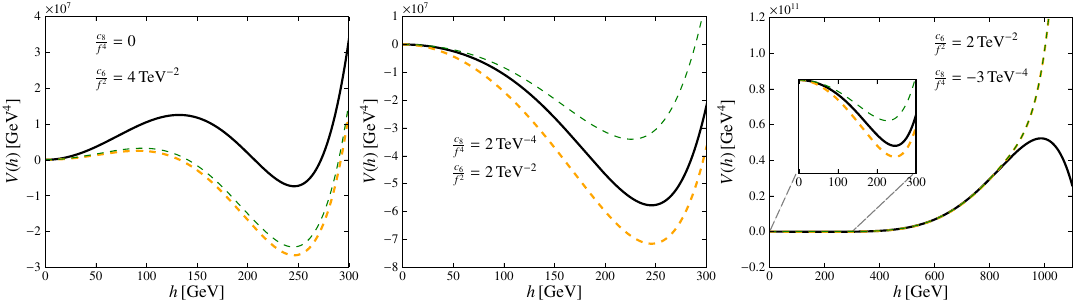
Figure 1 . The potentials V tree (black solid curve), V 1 ‘ at T = 0 (orange dashed curve) and V 1 ‘ at T = T x (green dashed curve) for the choices of c 6 =f 2 and c 8 =f 4 indicated in each panel. In the left panel, there exist two vacua already at zero temperature ( (cid:22) 2 ’ (cid:0) 3100 GeV 2 , (cid:21) ’ (cid:0) 0 : 23, T x = T c = 35 GeV ). In the central panel, the existence of two vacua arises only at (cid:12)nite temperature ( (cid:22) 2 = 1900 GeV 2 , (cid:21) = (cid:0) 0 : 06, T x = T c = 82 GeV ). In the right panel, the potential is unbounded from below, but the instability scale is above the cuto(cid:11) f = 1 TeV ( (cid:22) 2 = 3000 GeV 2 , (cid:21) = (cid:0) 0 : 03, T x = T n = 99 GeV ). T c is the critical temperature obtained in the mean-(cid:12)eld